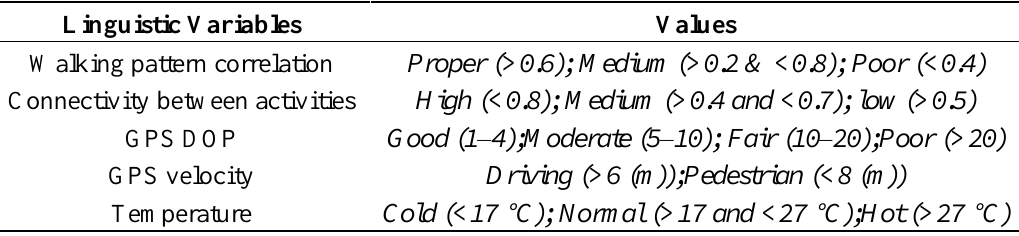
Table 6. Definition of fuzzy input variables [20].